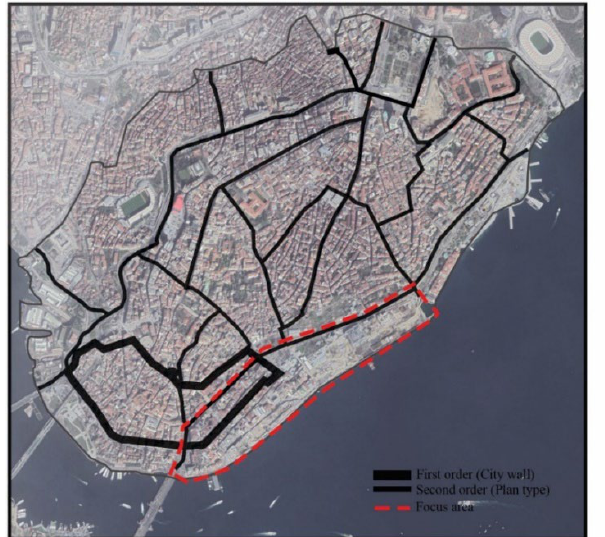
Figure 13 Plan units of Galata district showing general urban fabrics with 2019 aerial photos (first and second orders).